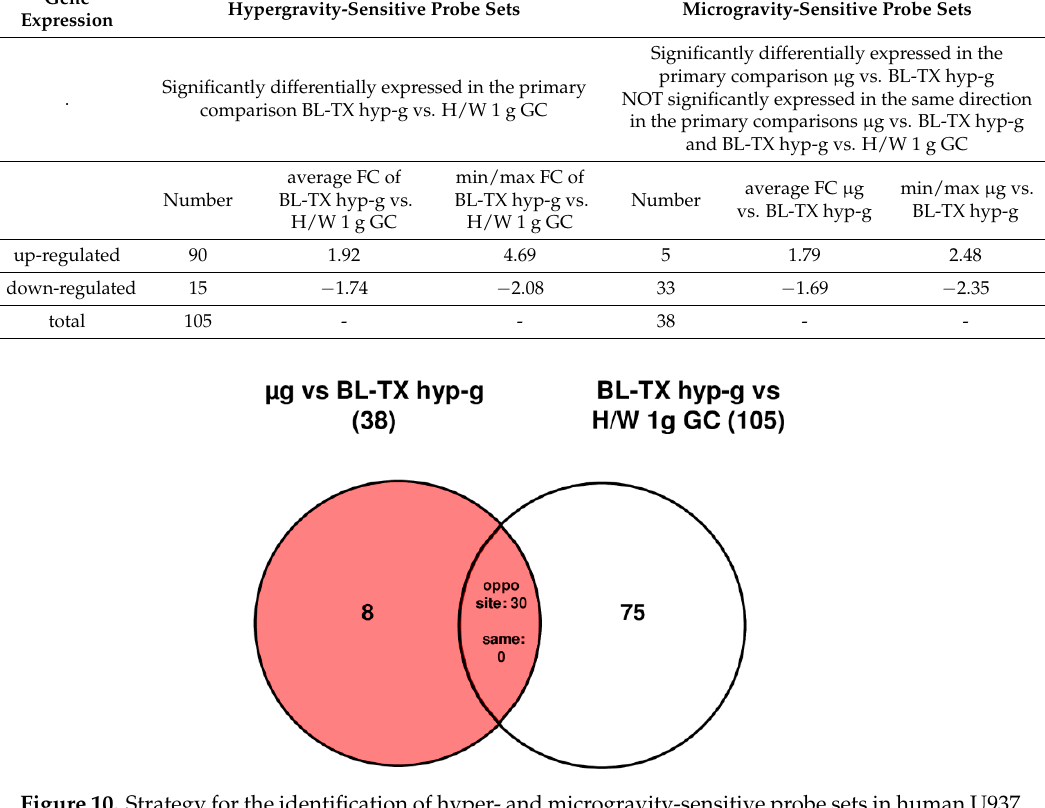
Figure 10. Strategy for the identification of hyper- and microgravity-sensitive probe sets in human U937 cells during the TEXUS-49 sounding rocket flight. The different comparisons and resulting intersections for hypergravity and microgravity-sensitive probe sets are displayed as Venn-diagrams. In the circles numbers of probe sets are given that are differentially expressed with a p -value < 0.05. The red area shows the number of BL-controlled (BL-PFC hyp-g versus H/W 1 g GC) microgravity-sensitive transcripts: differentially expressed in the comparison µg versus BL-TX hyp-g excluding those differentially expressed in the control comparison BL-TX hyp-g versus H/W 1 g GC that are regulated in the same direction. For the abbreviations of the experiment group names see Table